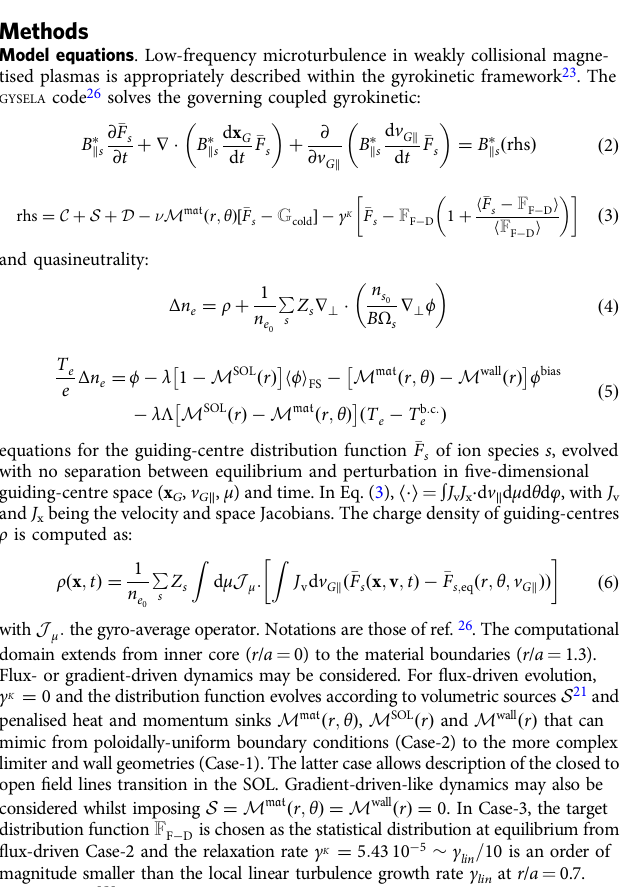
F (cid:3) D is chosen as the statistical distribution at equilibrium from fl ux-driven Case-2 and the relaxation rate γ K ¼ 5 : 4310 (cid:3) 5 (cid:7) γ lin = 10 is an order of magnitude smaller than the local linear turbulence growth rate γ lin at r / a = 0.7. Imposing M SOL ð r Þ as in Case-2 or cancelling this mask does not alter the dynamics which is dominated by the BGK operator [last term of Eq. (3)], speci fi cally described in ref. 53 and built such as to prevent overdamping zonal modes 11 . Penalisation 54 modi fi es the equations through introduction of a series of masks M mat ð r ; θ Þ , M SOL ð r Þ and M wall ð r Þ , combinations of hyperbolic tangents, adjustable in location, shape (for M mat ð r ; θ Þ ), and stiffness. They are illustrated in Fig. 6. Electrons have a Boltzmann response modi fi ed by penalisation such that the electric potential ϕ in the quasineutrality equation is relaxed towards its expected presheath condition Λ T e / e in the SOL. Additionally, ϕ may be biased to ϕ bias in the limiter ( ϕ bias = 0 in the current study) and is freely evolving elsewhere. T b : c : e is the cold electron temperature within limiter and wall, chosen as the minimum T e value within